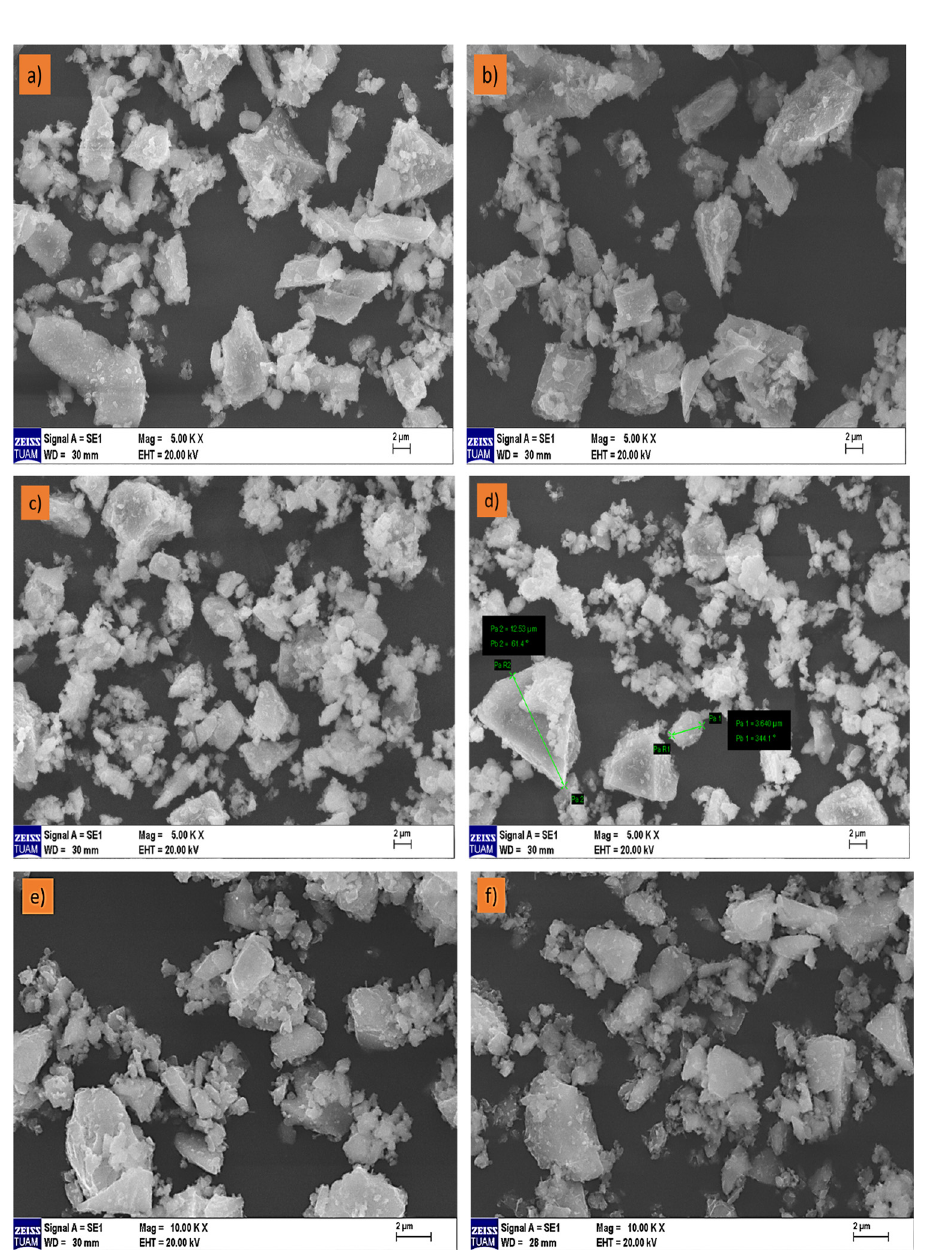
Figure 8: Fifteen - minute grinding time of 50% GVT - blended cement ( a ) and 50% BVT - blended cement ( b ) ; 30 min grinding time of 50% GVT - blended cement ( c ) and 50% BVT - blended cement ( d ) ; and 45 min grinding time of 50% GVT - blended cement and ( e ) 50% BVT - blended cement ( f )